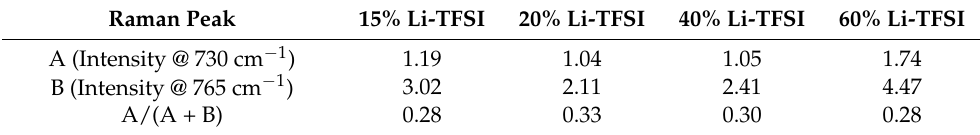
Table 2. Raman intensity analysis to quantify abundance of oxidized spiro-OMeTAD in the cells. Raman